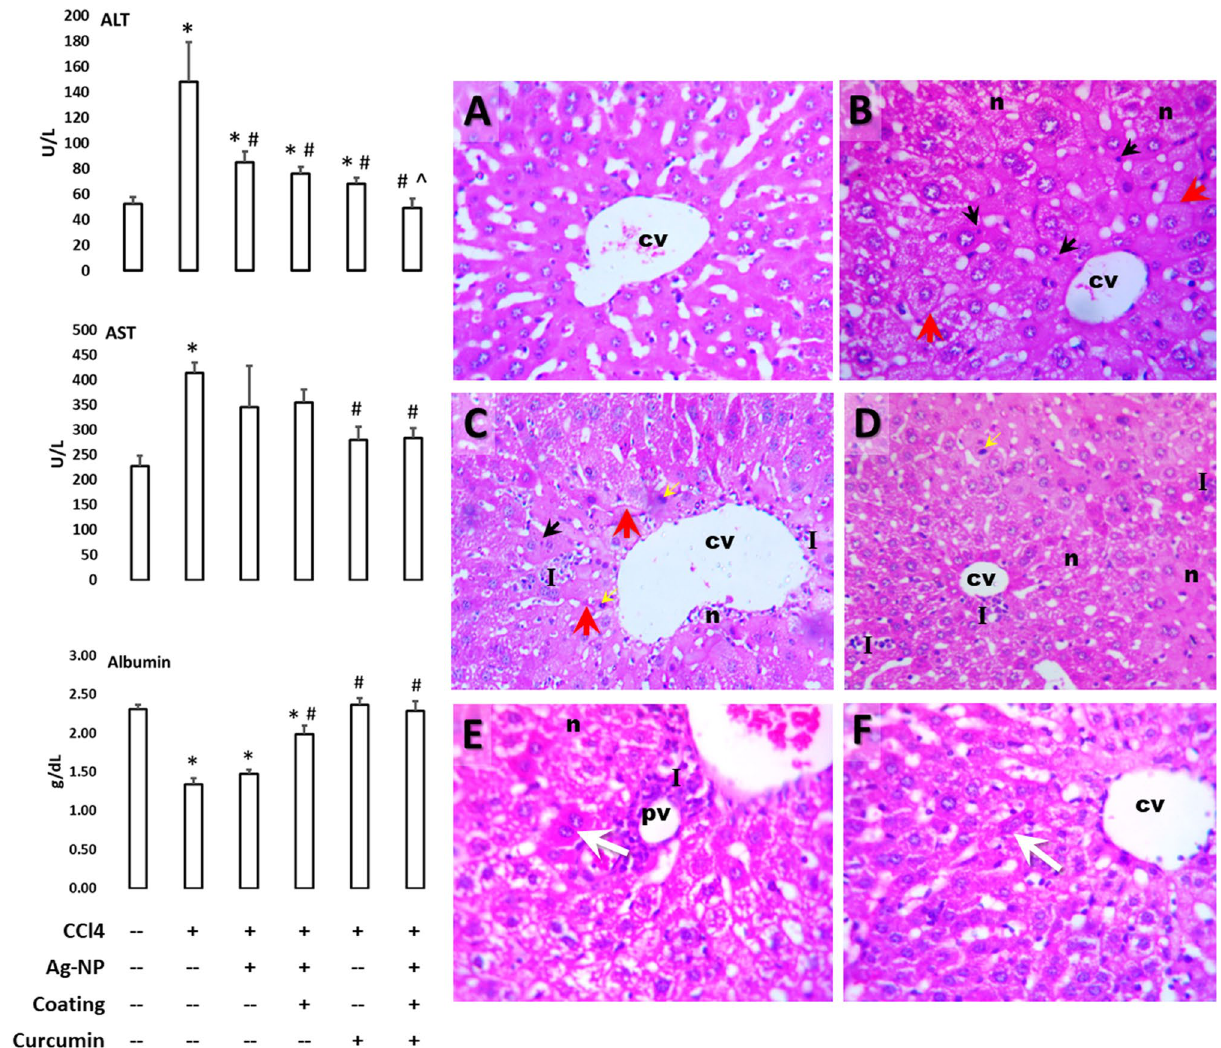
Figure 2. The green synthesized curcumin/chitosan-coated silver nanoparticles maintain the liver structure and function of CCl 4 -mouse fibrosis model. Mice were treated twice a week with CCl 4 and once a week with different nano treatments or curcumin for 5 weeks. Left panel: serum levels of the hepatic enzymes AST and ALT, and albumin after different treatments as a liver function test. Statistical analysis: ANOVA P < 0.05; * = significantly different from the control value; # = significantly different from value of CCl4-fibrosis group; ^ = significantly lower than the value of curcumin-treated group (posthoc t-test after ANOVA). Right panel: hepatic histological changes (H&E, 200x) from negative control group ( A ) due to fibrosis induction by CCl 4 ( B ) and treatment of this fibrosis group with AgNPs ( C ), chitosan-coated AgNPs ( D ), curcumin ( E ), or curcumin/ chitosan-coated AgNPs ( F ). Abbreviations: cv, central vein; pv, portal vein; n, necrosis, I, necrotic foci with leukocytic infiltration; dark arrows show apoptotic microneuclei; red arrows, fibrotic thickenings; white arrows, binucleated